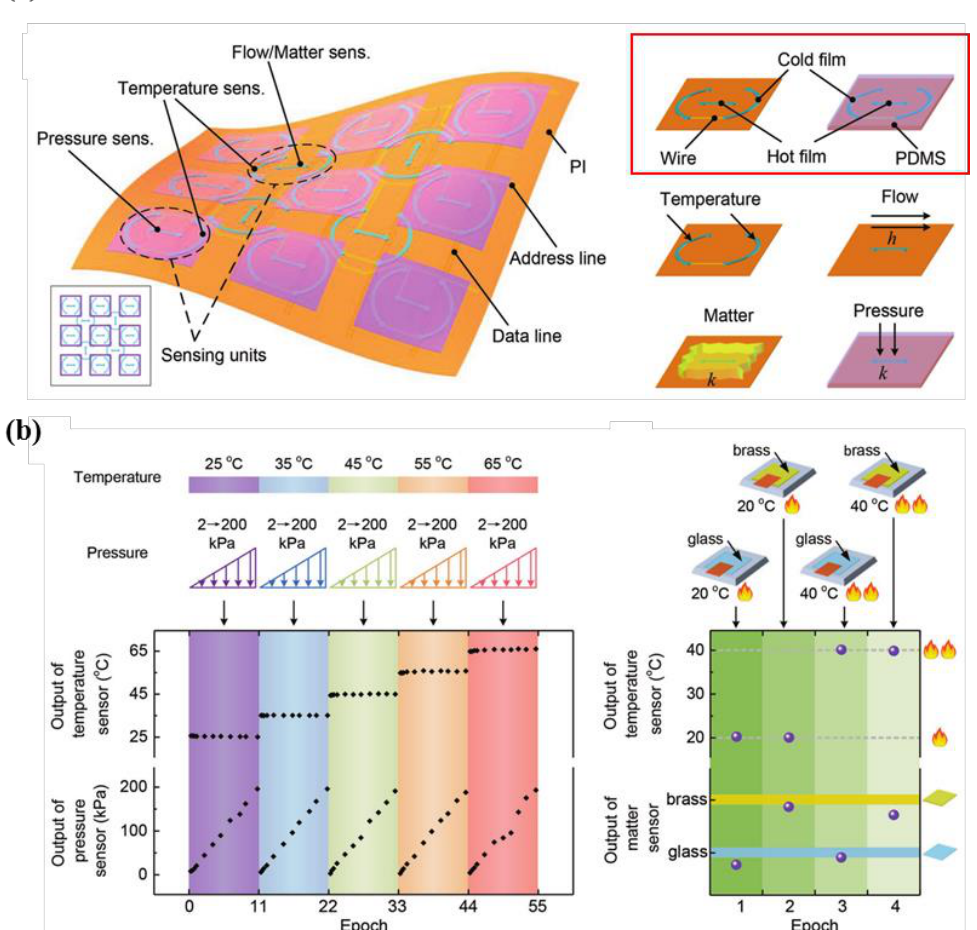
Figure 15. ( a ) Schematic illustration showing the structure of multi-functional e-skin (left) and units (right) including flow, matter, temperature, and pressure sensor; ( b ) multiple performance of the fabricated e-skin (reprinted with permission for Figure 15a,b from Ref. [141] Copyright 2017 John Wiley and Sons).